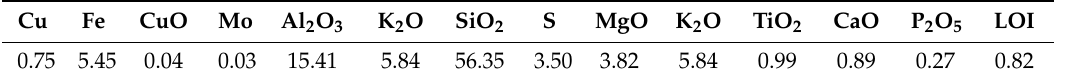
Table 1. Chemical composition (wt.%) of the studied sample.